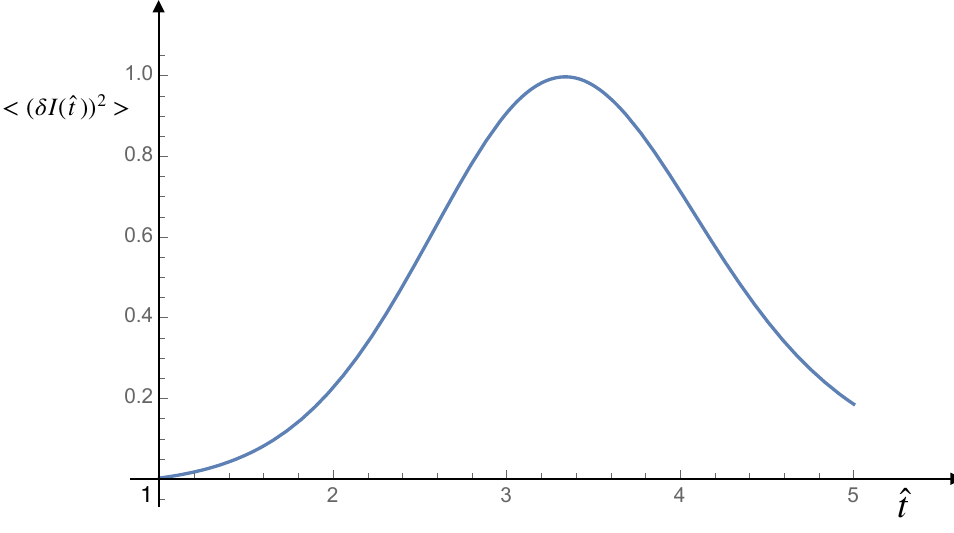
Figure 6. Correlation Function < ( δ I ( ˆ t )) 2 > for Italy, first wave of infection by SARS-CoV-2. This correlation function corresponds to the solution of Equation (35). The values of the parameters are I 0 = 5,000, K = 150,000, α = 1.5, and β = 0.1,